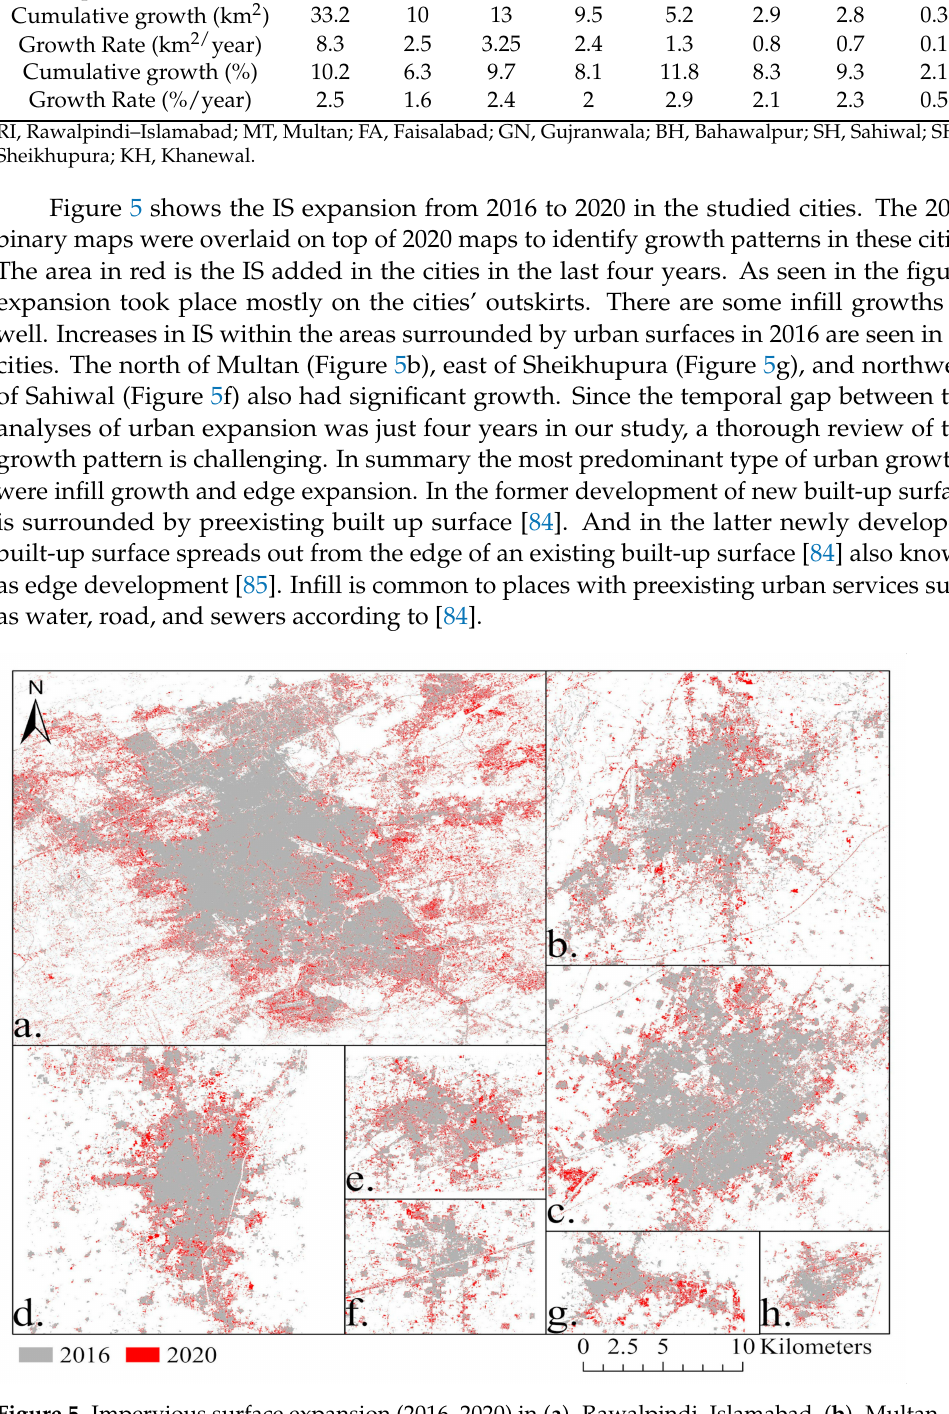
Figure 5. Impervious surface expansion (2016–2020) in ( a ). Rawalpindi–Islamabad, ( b ). Multan, ( c ). Faisalabad, ( d ). Gujranwala, ( e ). Bahawalpur, ( f ). Sahiwal, ( g ). Sheikhupura, and ( h ).